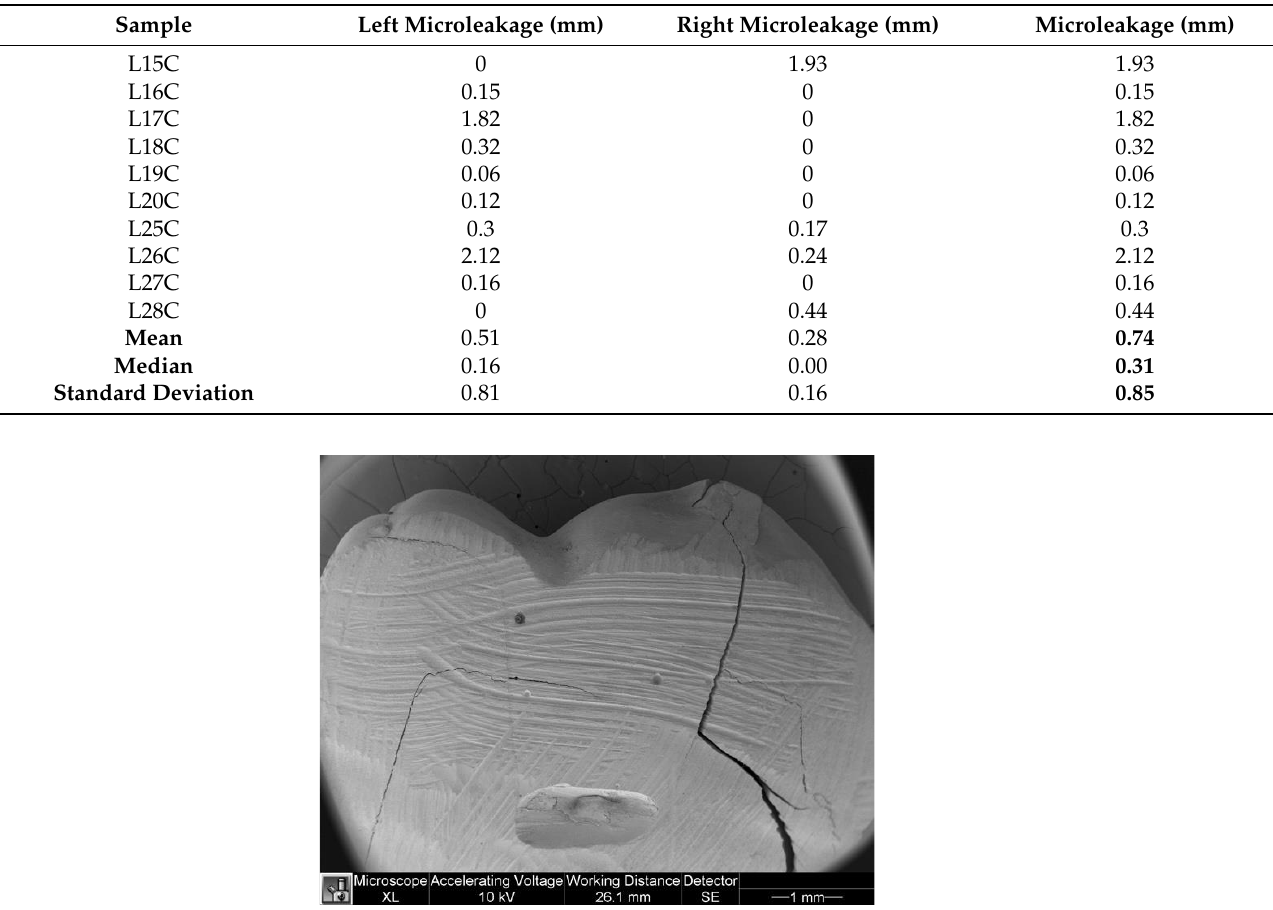
Figure 6. Microleakage in a specimen of control group. 3.2. Marginal Adaptation The following tables show the marginal adaptation data between the two groups (Ta- bles 3 and 4). The U Mann-Whitney test showed no statistically significant differences between groups ( p = 0.821). Figures 7 and 8 show marginal adaptation in specimens. Table 3. Marginal adaptation in the study group. Sample